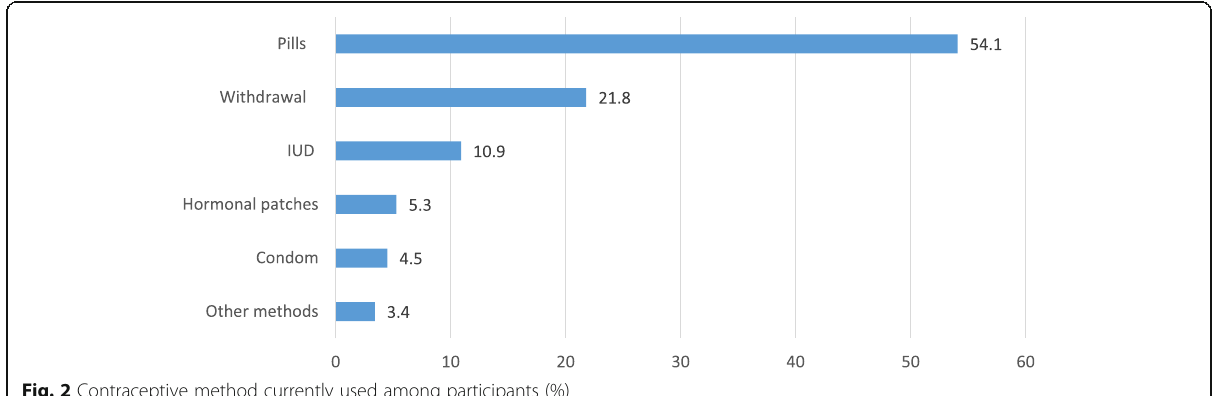
Fig. 2 Contraceptive method currently used among participants (%)